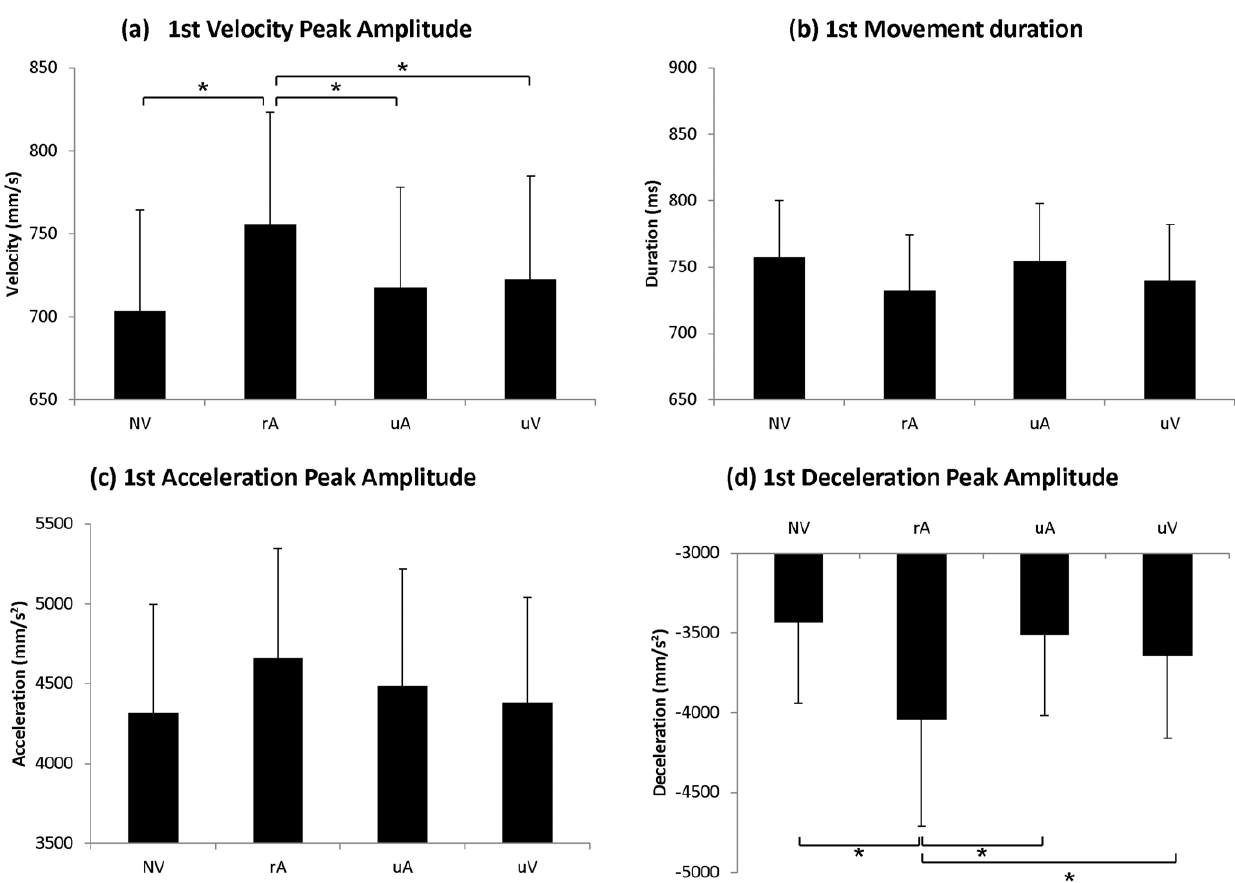
Figure 5. Experiment II: Kinematic parameters of ‘‘Reach-to Grasp’’ movement. Mean values of (a) wrist velocity peak amplitude (b) movement duration (c) wrist acceleration peak amplitude and (d) wrist deceleration peak amplitude. Error bars represent standard error or the mean (SEM). *p , 0.05.